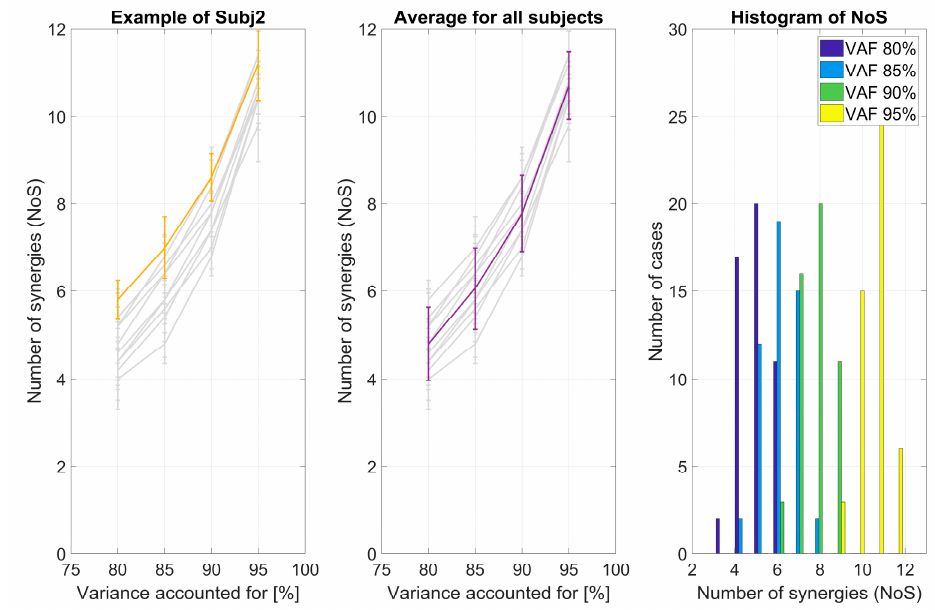
Figure 10. For each subject, the NoS is portrayed for each of the four selected VAF thresholds and how NoS varies between five considered sessions. The example of the mean and standard deviation of the NoS for one typical subject (Subj 2) in comparison with all the others is shown ( a ) as well as total mean and STD for all subjects and sessions ( b ). For each of the four VAF levels, a histogram portrays the number of cases in which a specific number of synergies was extracted. The higher the threshold, the higher the average number of extracted synergies ( c ).